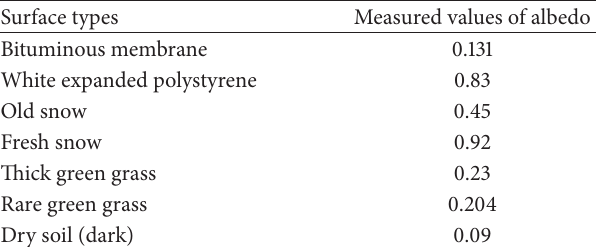
Table 1: Measured values of